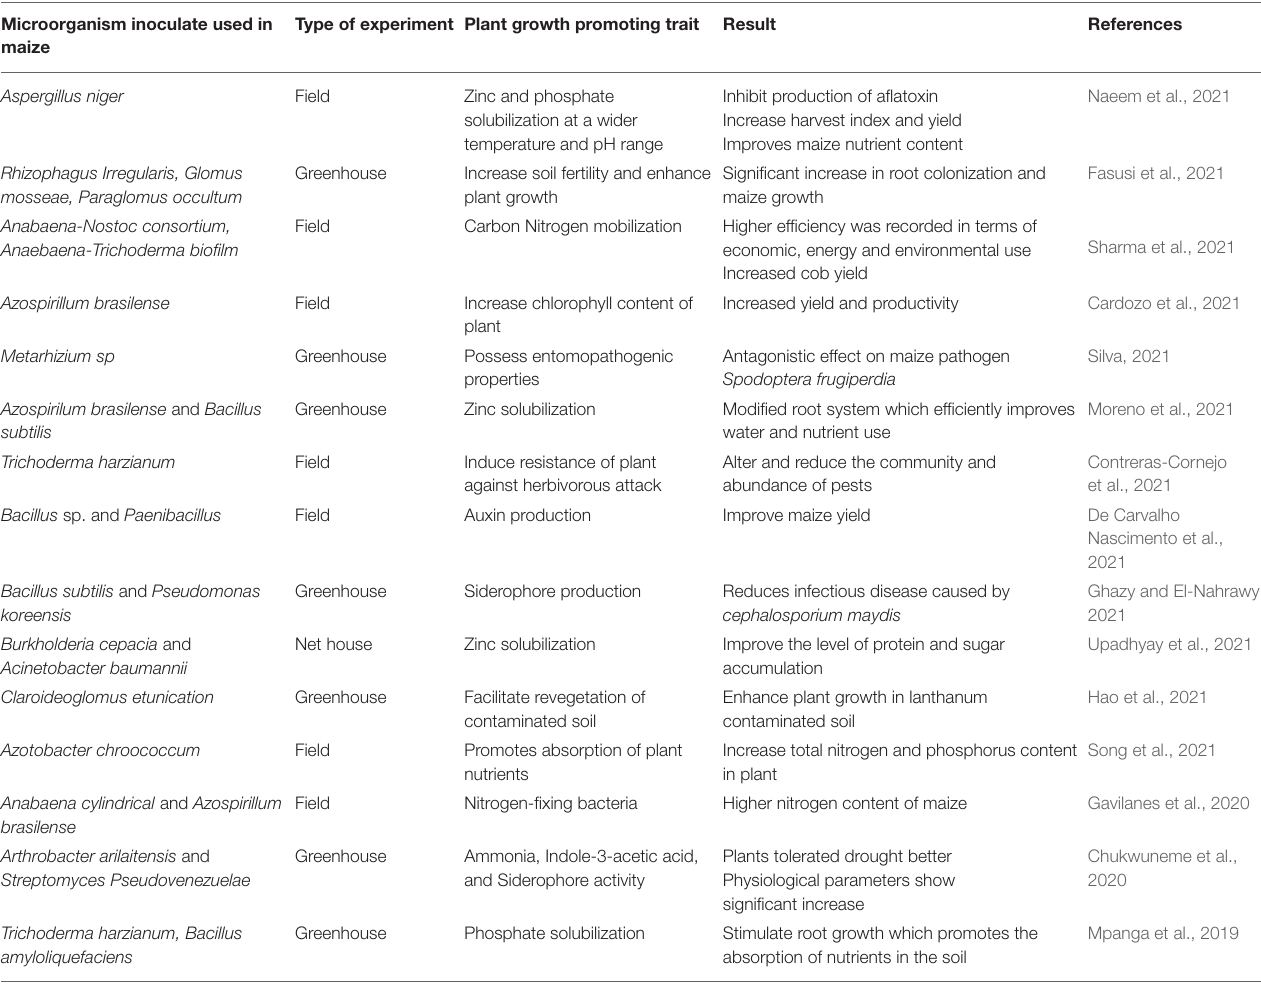
TABLE 2 | Microorganism with plant growth-promoting traits that have been used on